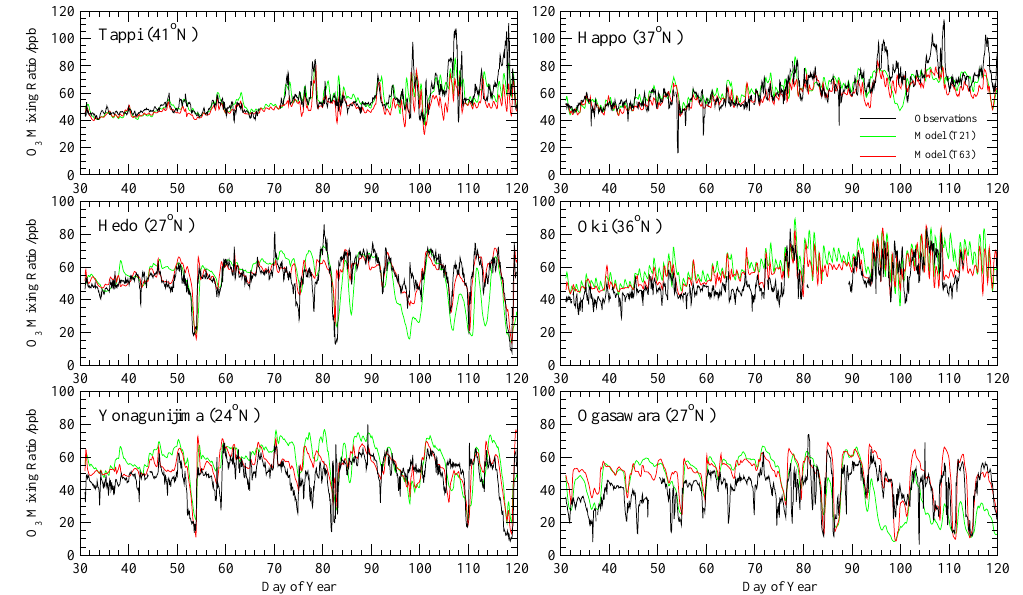
Fig. 4. Time series of hourly-mean O 3 observations at selected remote EANET and WMO/GAW measurement sites in February–April 2001 (black) and FRSGC/UCI CTM results at T21 (green) and T63 (red) resolution. Table 2. Statistical Summary of Observed and Modeled Hourly Surface O 3 (in ppb) in February–April